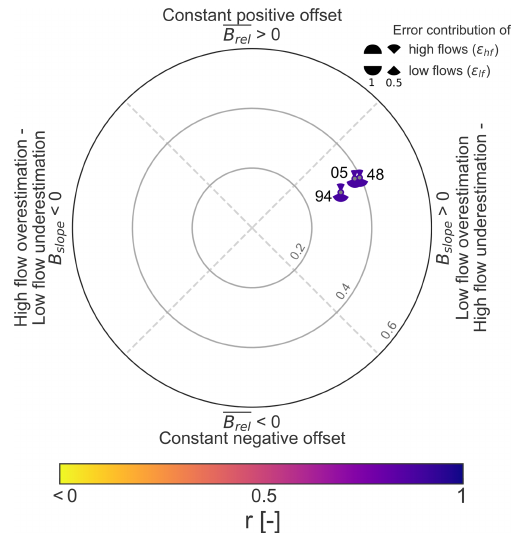
Figure 5. Diagnostic polar plot for the modelling example. Simula- tions were realized with three different parameter sets (05, 48, 94; see Fig. 4). All simulations perform well. However, the remaining error is dominated by a negative dynamic error type, while timing is